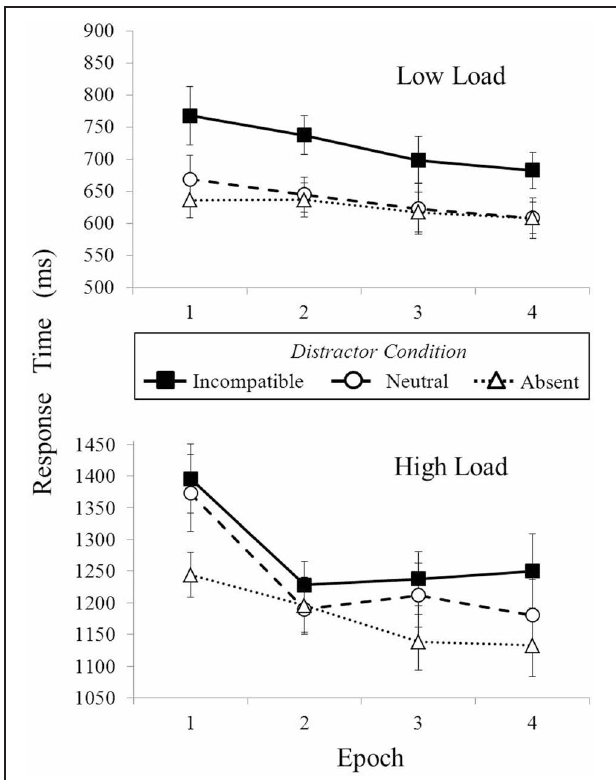
FIGURE 3 | Mean RTs (in ms) shown as a function perceptual load and distractor condition in Experiment 1. Epoch represents when during the experiment the trial occurred as divided into quarters. Error bars reflect the standard error of the